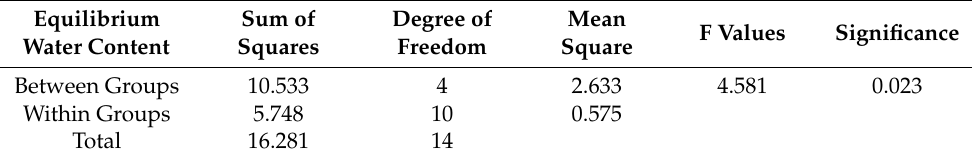
Table 4. ANOVA statistical analysis of membrane equilibrium water